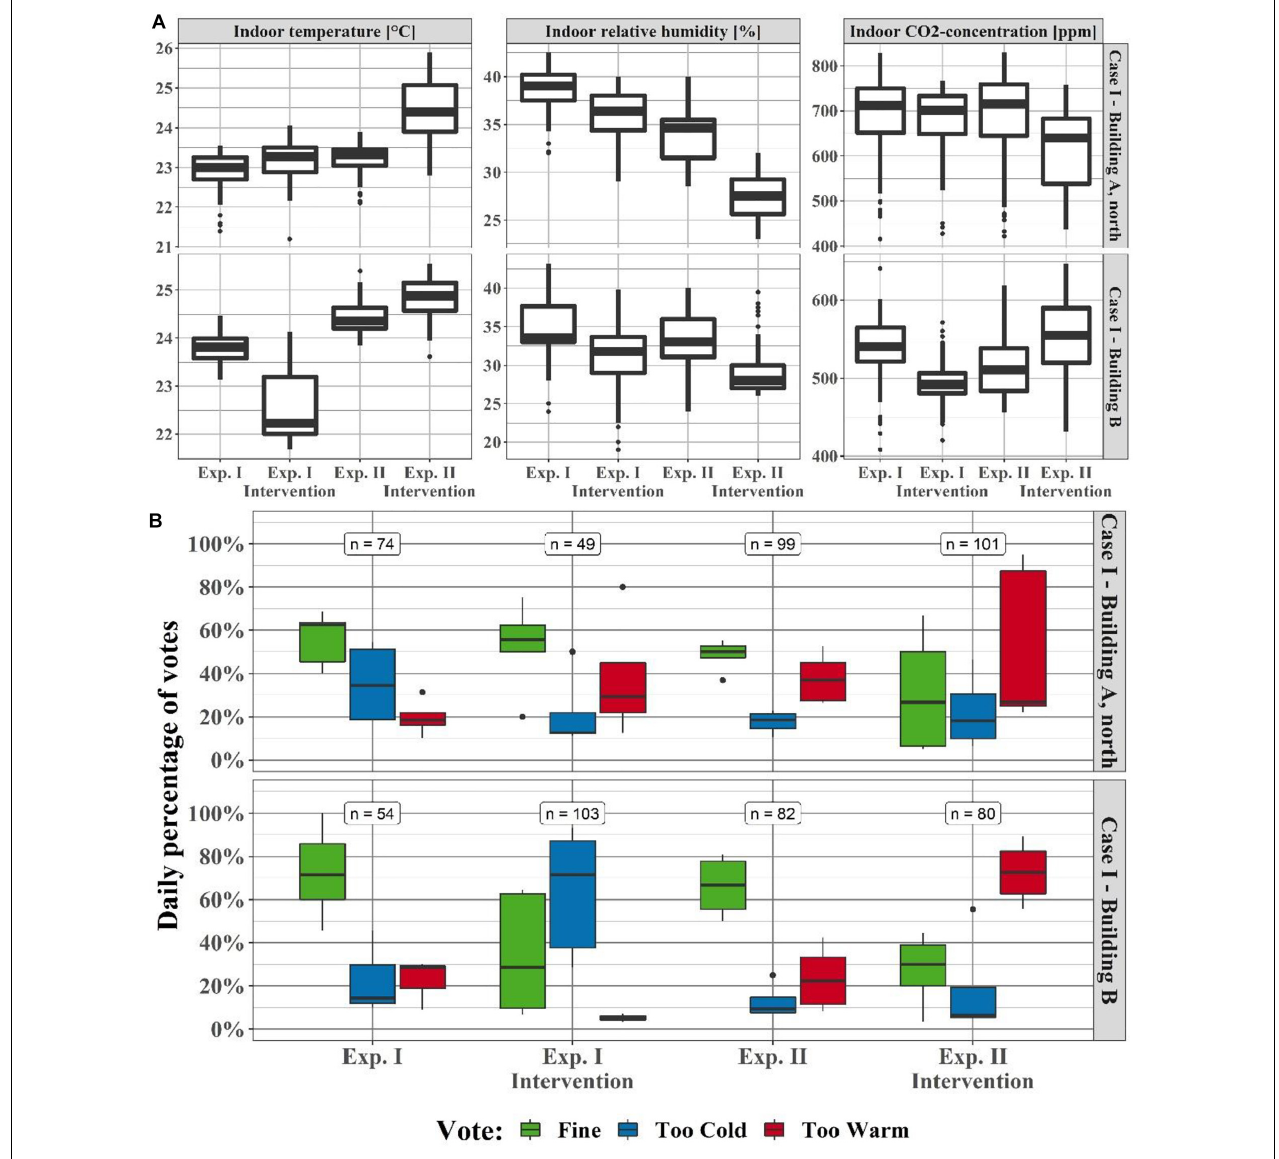
FIGURE 11 | Case I. (A) Boxplot of indoor temperature, relative humidity and CO 2 -concentration during occupied hours. (B) Daily percentage of votes cast with TiAQ. “Ill-willed” votes were